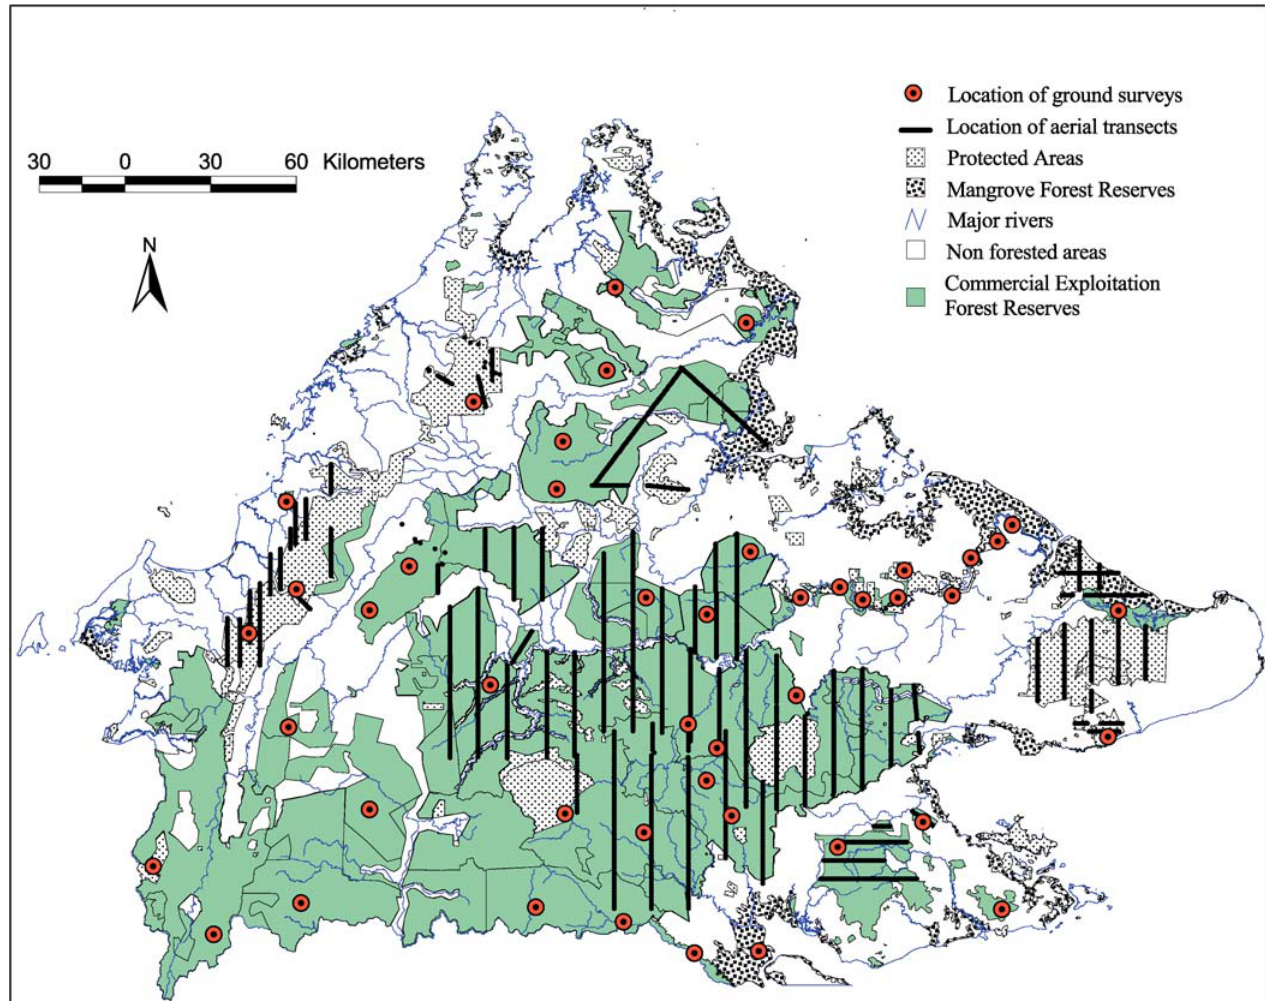
Figure 2. Location of Ground and Aerial Surveys during the Orangutan Census in Sabah, Malaysia, Borneo Aerial transects are not shown for the Lower Kinabatangan forests. DOI: 10.1371/journal.pbio.0030003.g002